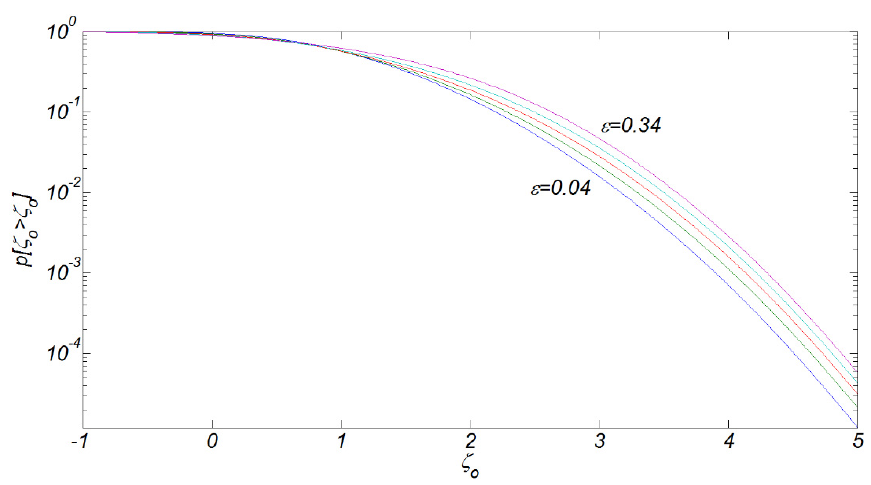
ς > ς of wave crest height o ο